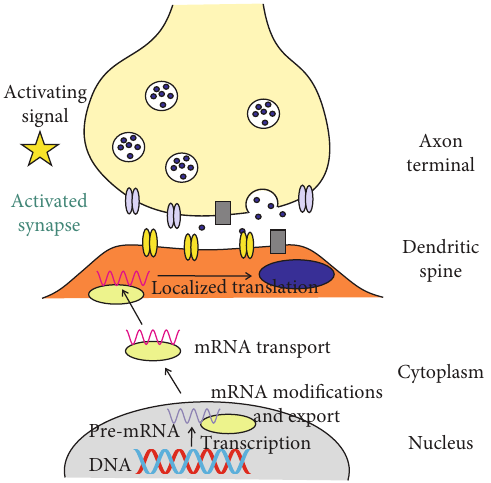
Figure 1: Localized expression of genes is crucial for activity- dependent synaptic modi fi cation. Synapse-activating signal (yellow star) may belong to a wide range of stimuli, including behavioral experience. Activated synapse sends a signal to the nucleus to transcribe a gene whose product is needed to modify the synapse. Pre-mRNA is exported to the cytoplasm and can be transported to the site of synaptic modi fi cation, where it is translated to produce a protein (dark blue oval) needed for synaptic modi fi cation. Alternatively or concomitantly, mRNA may be translated immediately after export to the cytoplasm and the product of translation is transported to the target site (not shown). Light green oval symbolizes all proteins that are needed for pre-mRNA maturation, export, and transport. Neurotransmitters (blue dots) are encapsulated in synaptic vesicles and released into synaptic cleft and are taken up by their receptors (yellow ovals); voltage-gated channels and neurotransmitter reuptake pumps are presented as dark grey box and light blue ovals,